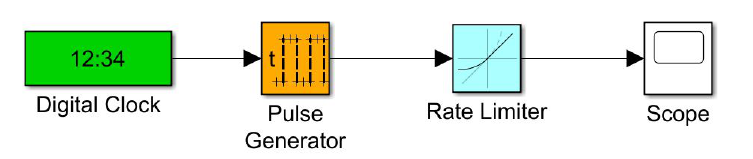
Figure 3. Triangular signal design.